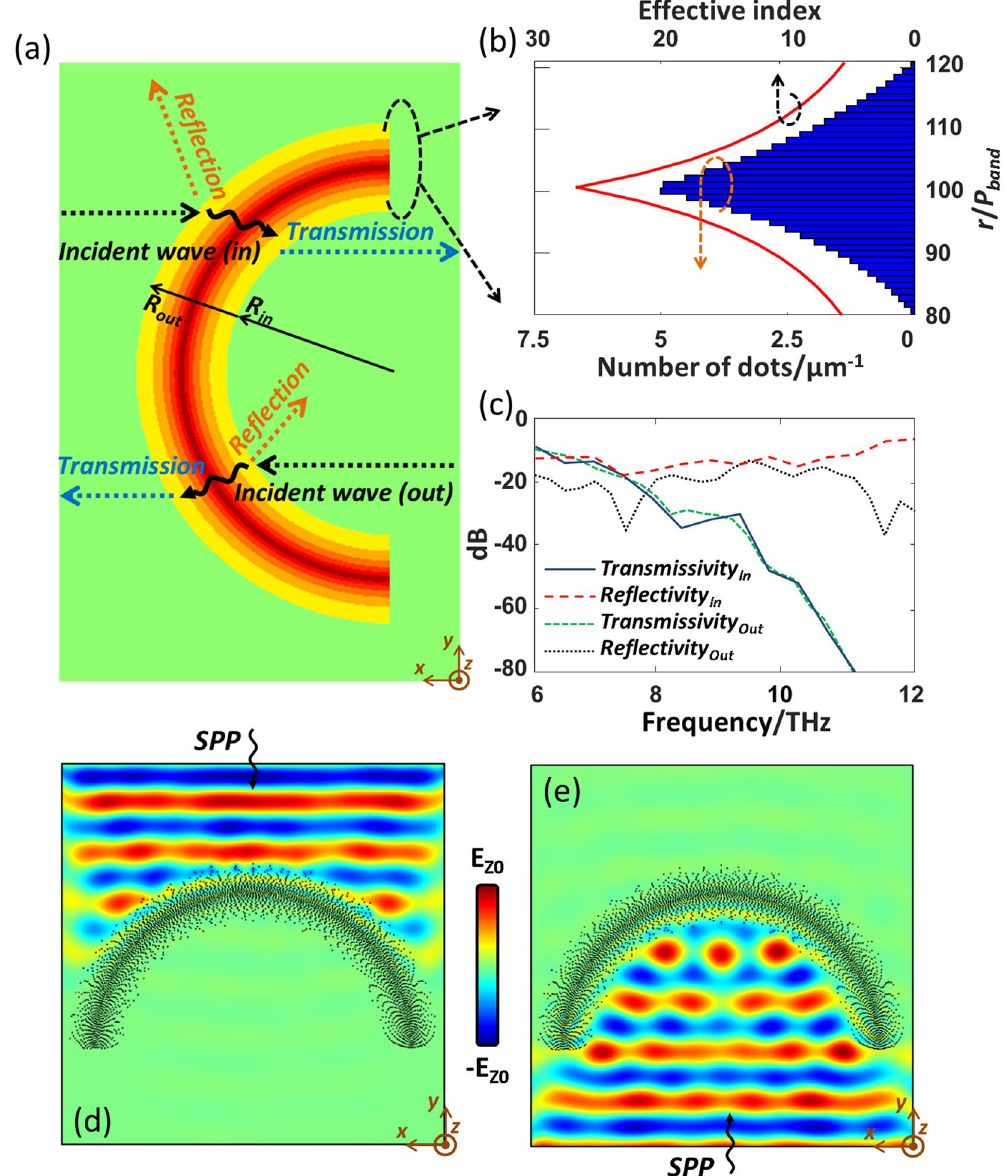
Figure 6. ( a ) Illustration of reflections and transmissions with inward and outward incident waves. ( b ) The dot density distribution of the designed black ring and the corresponding effective index. ( c ) The simulated transmissivities and reflectivities with inward and outward incident waves. ( d , e ) Field distributions of the black semi-ring illuminated with inward and outward incident waves at 8